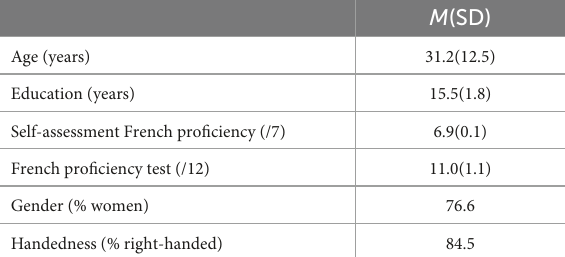
TABLE 1 Demographic data: Means ( M ) and standard deviations (SD) for N = 788 participants of Experiment 1.